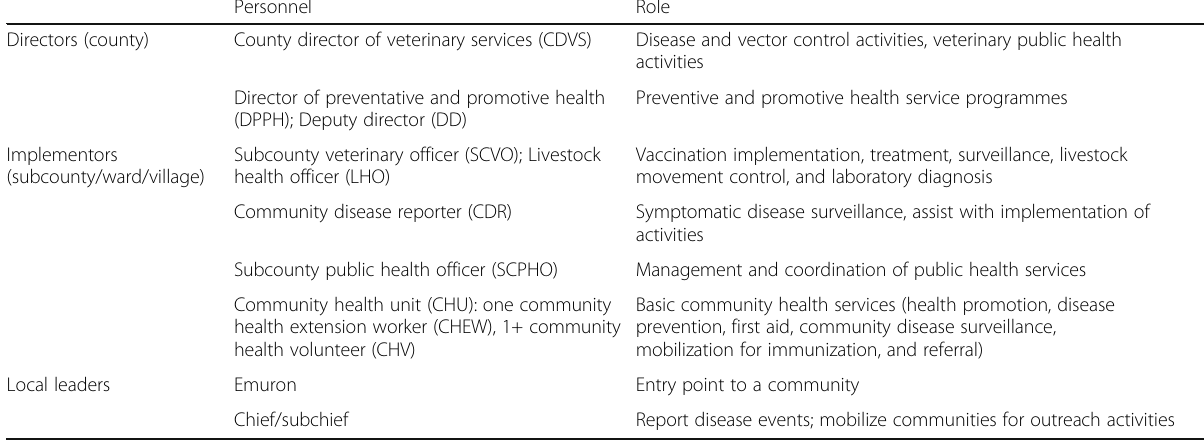
Table 1 Government personnel and local leaders involved in public health and animal health activities in Turkana County